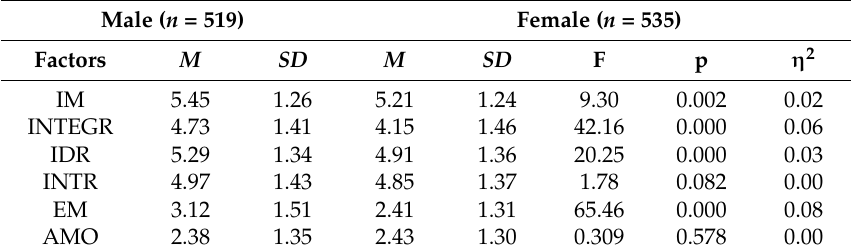
Table 4. Univariate analysis by